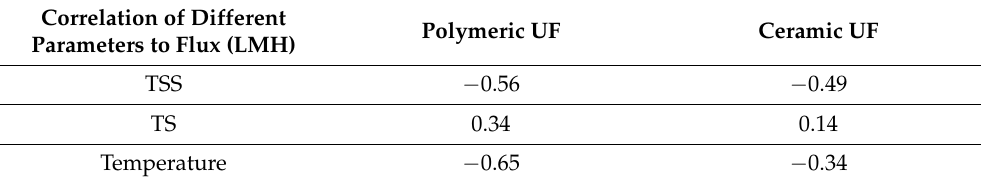
Table 5. PPMCC correlation table of different parameters to Flux